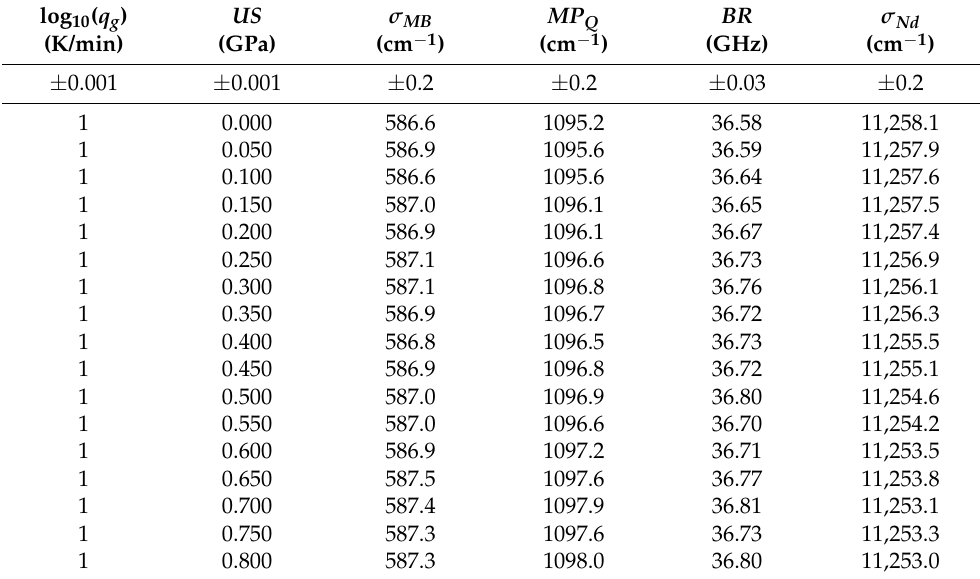
Table A3. Experimental data and spectroscopic observables of the US_T g 1 sample used for the multiple linear regression